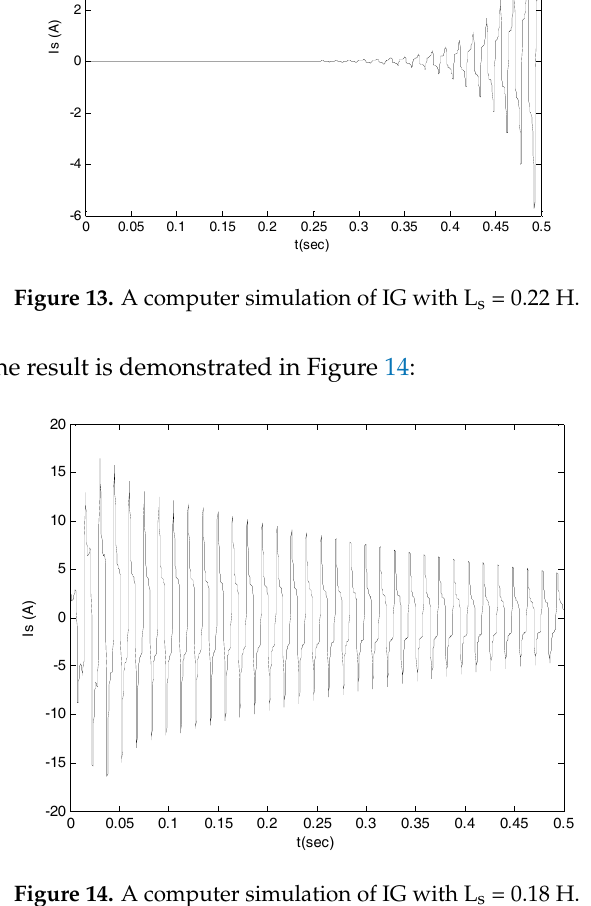
Figure 14. A computer simulation of IG with L s = 0.18 H.